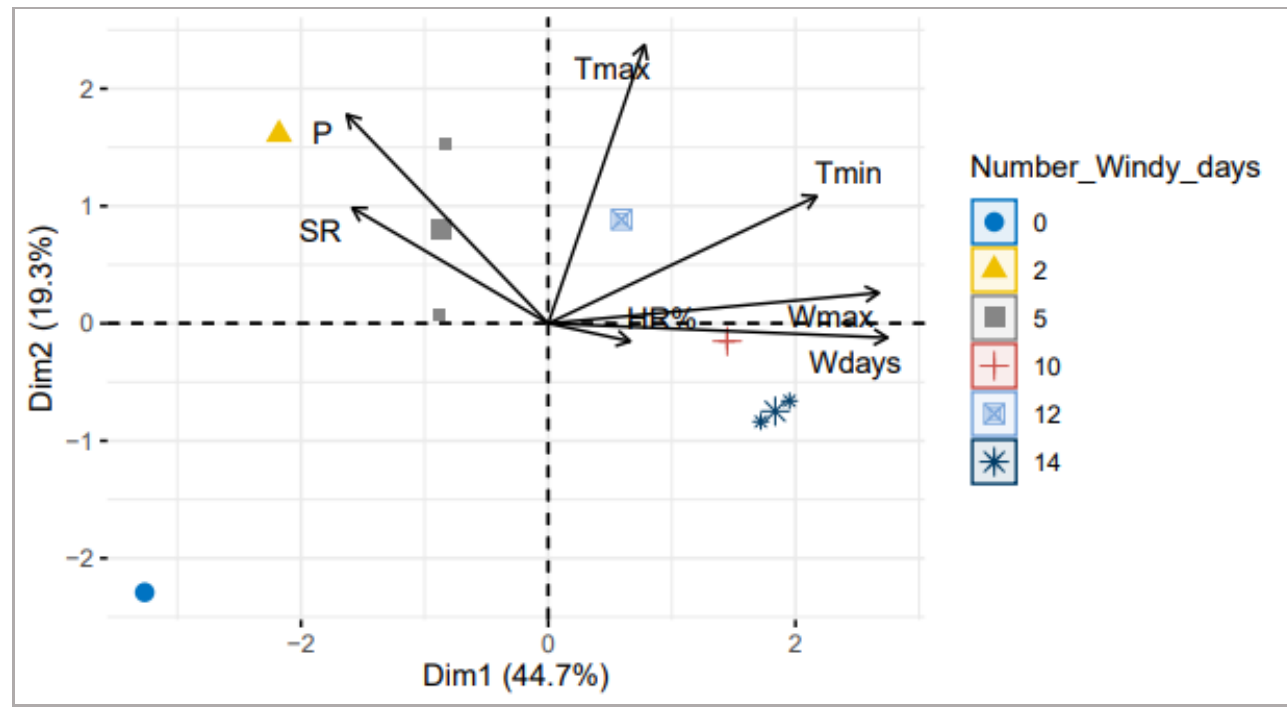
Figure 3. Distribution of SR trap nurseries clustered based on the number of windy days (Wdays) on two dimensions principal component analysis (PCA) plot of disease occurrence (SR), P (precipitation, mm), Tmax (average maximum temperature, ◦ C), Tmin (average of minimum temperature, ◦ C), HR% (average of relative humidity, %), Wmax (average of maximum wind speed), and Wdays (number of windy days) during the three spring months (March, April, and May) of both 2021 and 2022 cropping seasons.